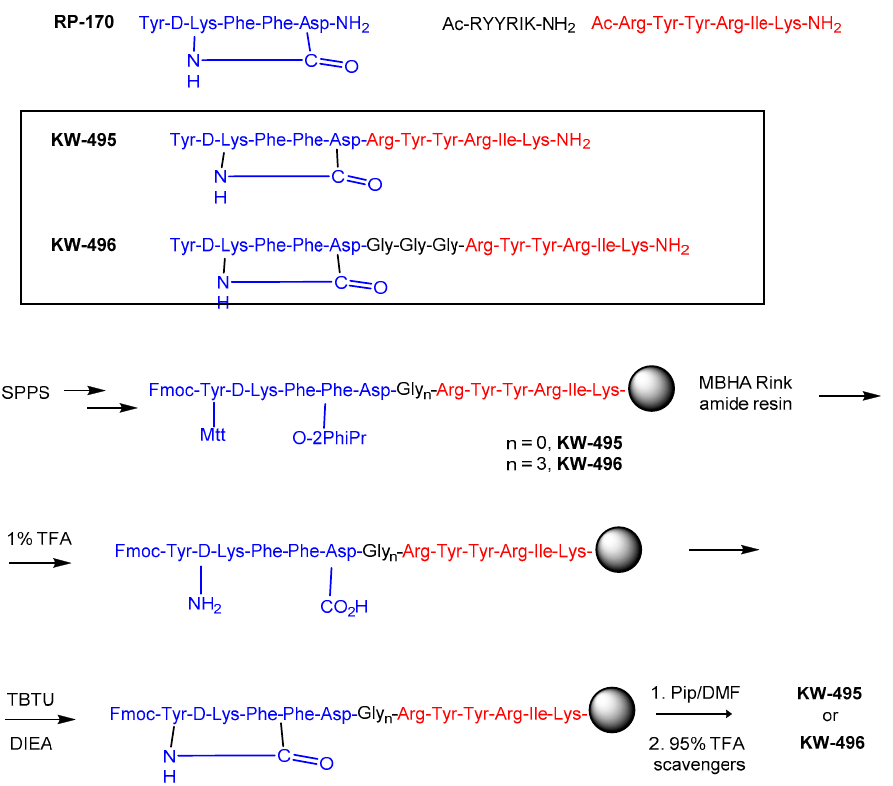
Figure 1. Structures of the parent peptides RP-170 and Ac-RYYRIK-NH 2 and of the hybrid derivatives KW-495 and KW-496 , and the synthetic strategy.